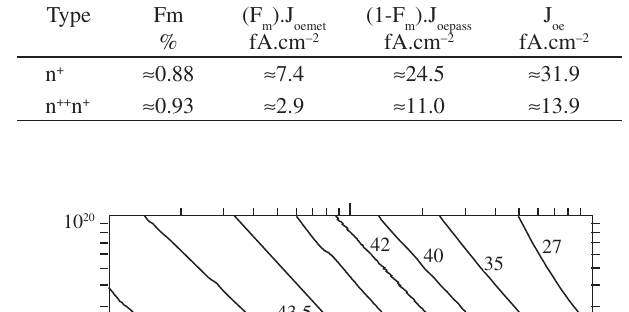
Table 1. Comparison between the homogeneous and DD emitter recombina- tion current density for the optimum complete structures from Figure 8 and 11: the components multiplied by the weight factors, (F ).J and (1-F ). m oemet m J , and the total, J . oepass oe Type Fm (F ).J (1-F ).J m oemet m oepass % fA.cm –2 fA.cm –2